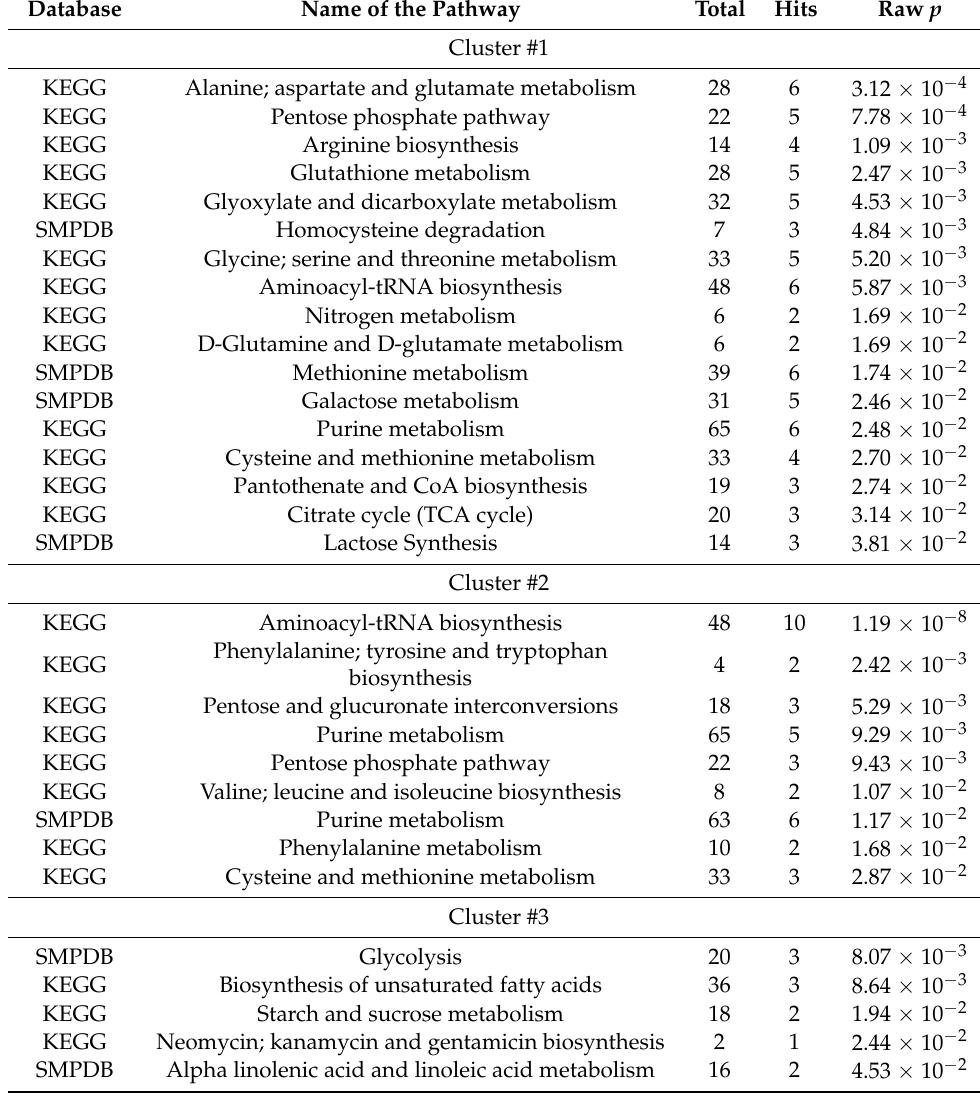
Table 2. Overview of the top results of pathway analysis ( p -value < 0.05) conducted against SMPDB and KEGG databases for clusterized metabolites (sorted by increasing p